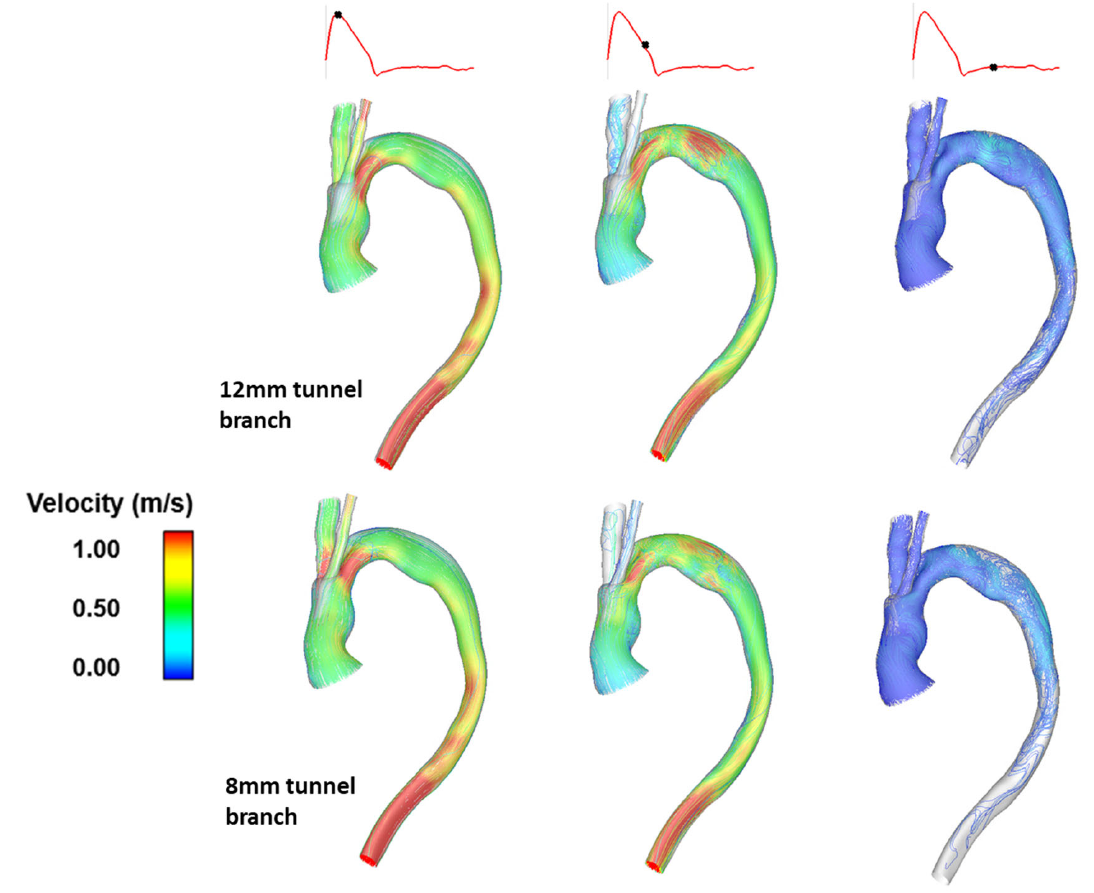
Figure 8. A comparison of instantaneous velocity streamlines in post ‐ TEVAR models for a single patient with different tunnel branch diameters (originally 12 mm, modified to be 8 mm), depicted at peak systole, mid ‐ systolic deceleration and diastole [74].